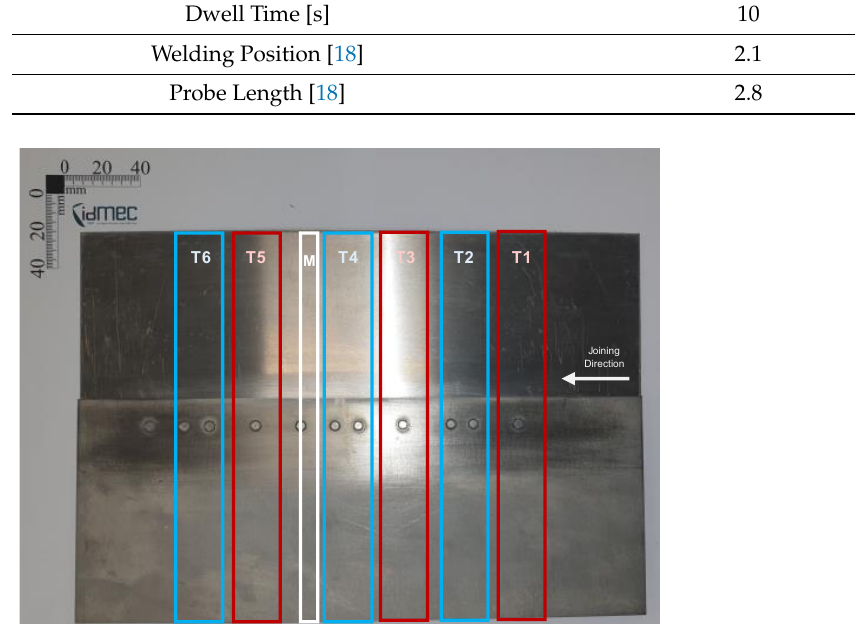
Figure 2. Scheme of the geometry and the relative position of the profiles drilled in titanium sheets (back view). All dimensions in mm.